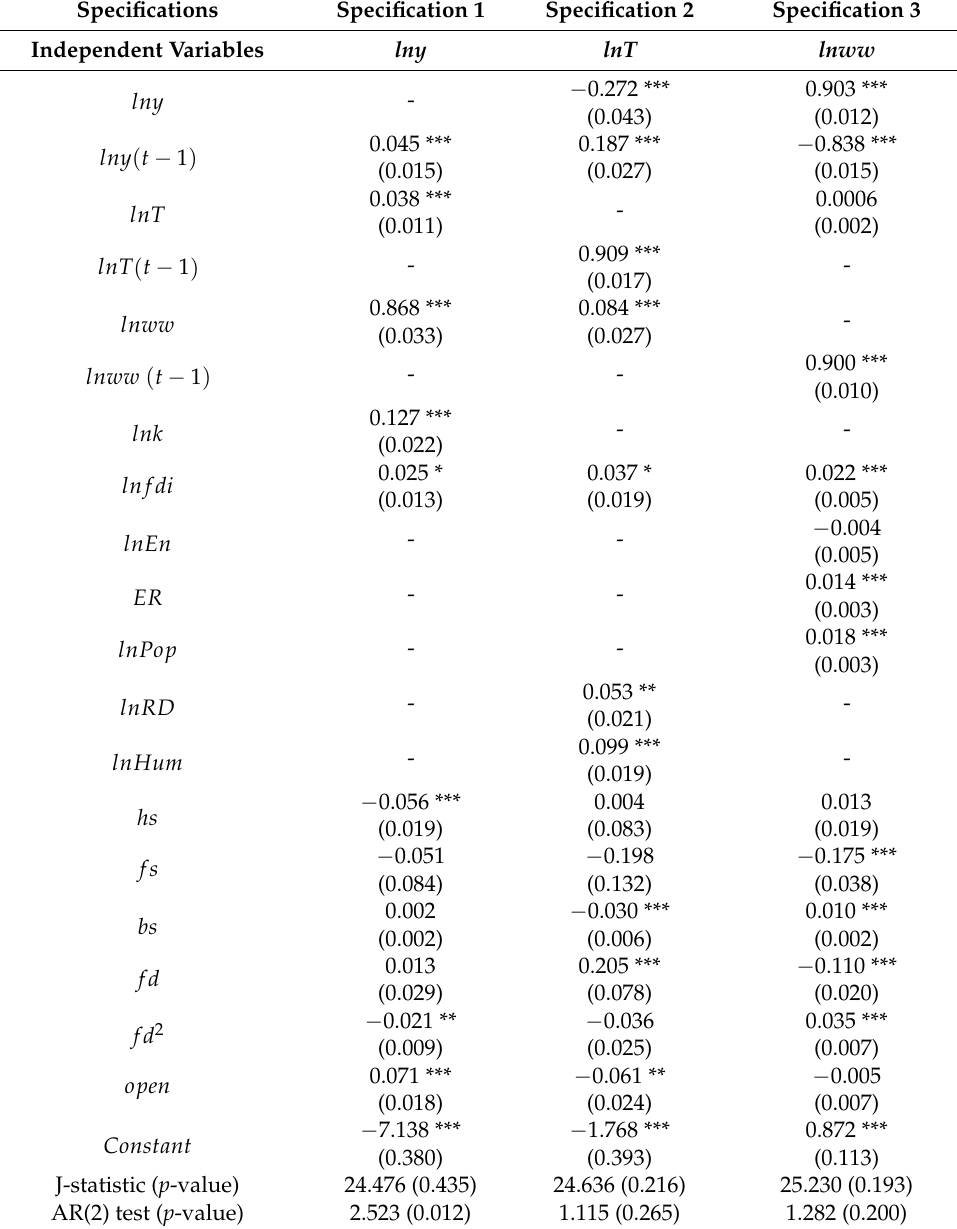
Table 7. GMM estimation results of panel simultaneous equations of Equations (11)–(13) ( R represents total wastewater discharge ( ww)